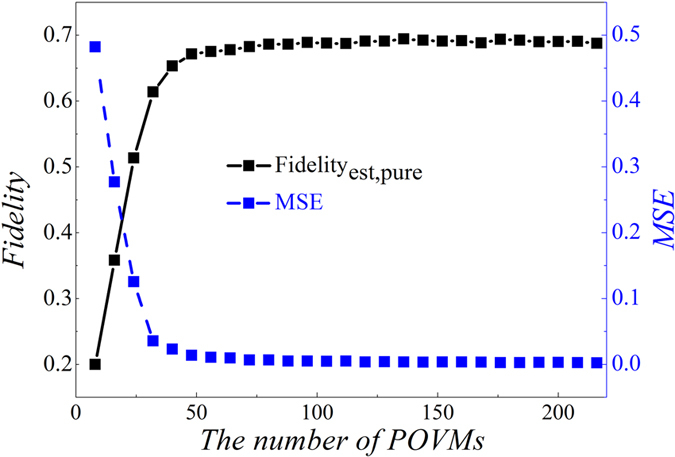
Fidelities and MSEs’ of state ρest under different number of POVMs.ρest is the estimated density matrix from ρexp_3qubits. The fidelity is calculated by . The MSE (Mean Square Error) is calculated by .